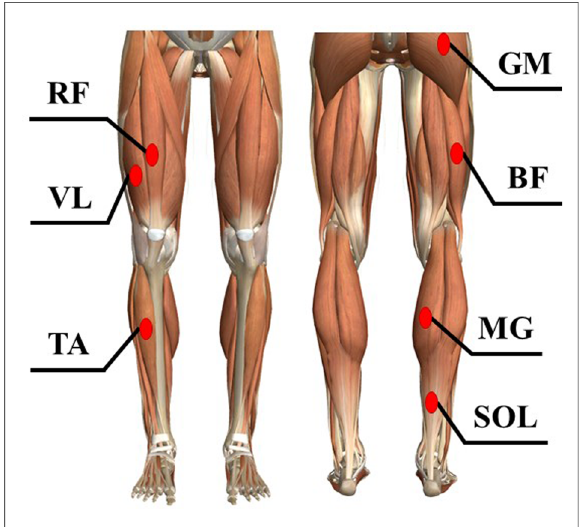
FIGURE 2 The measurement places of surface electromyography (EMG) of lower limb muscles. The EMGs were recorded and ampli fi ed from seven right lower limb muscles. GM; gluteus maximus, BF; biceps femoris, RF; rectus femoris, VL; vastus lateralis, MG; gastrocnemius medialis, SOL; soleus, TA; tibialis